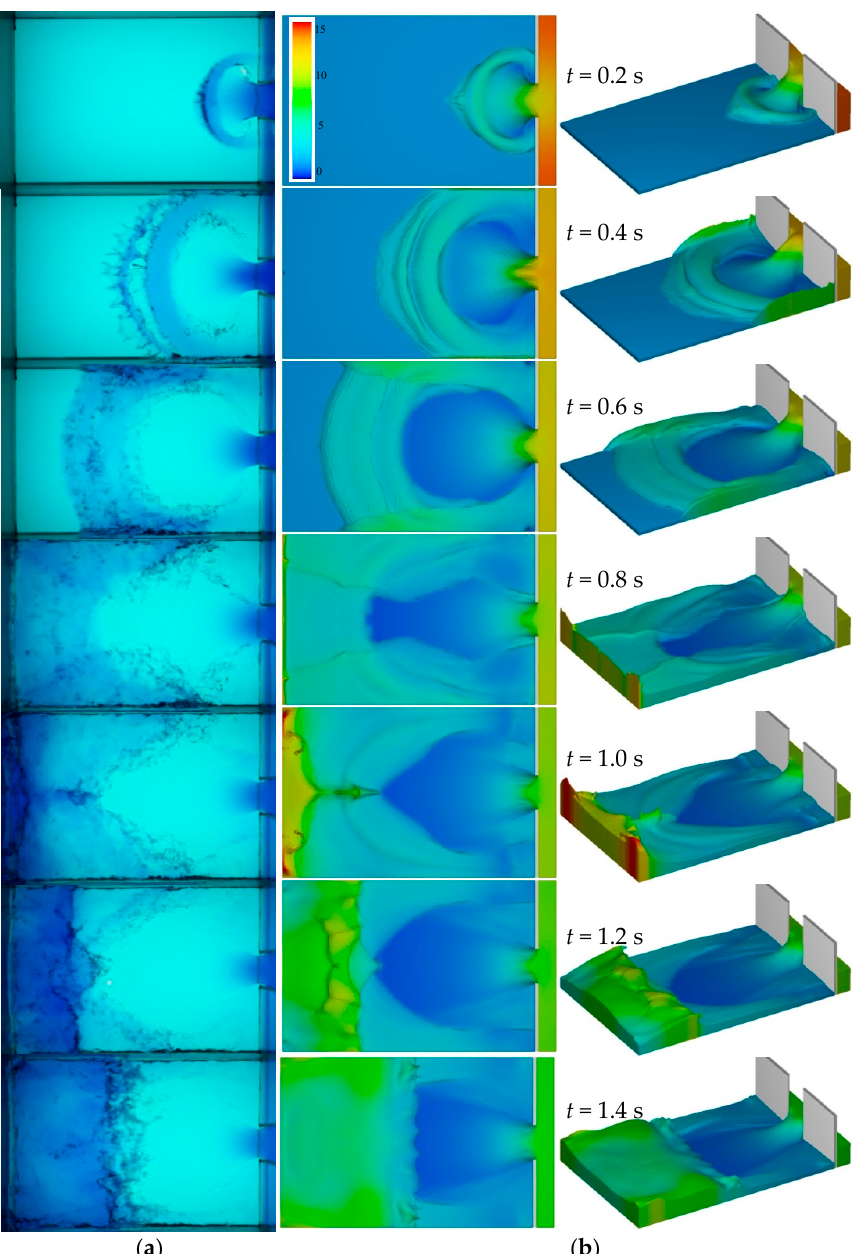
Figure 8. Comparison between experimental ( a ) and numerical ( b ) results for test W1 ( α = 0.1).